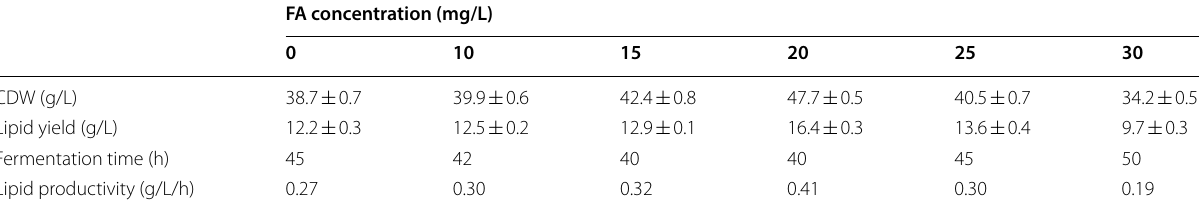
Data represent the mean values and standard deviations of three replicates for each measurement